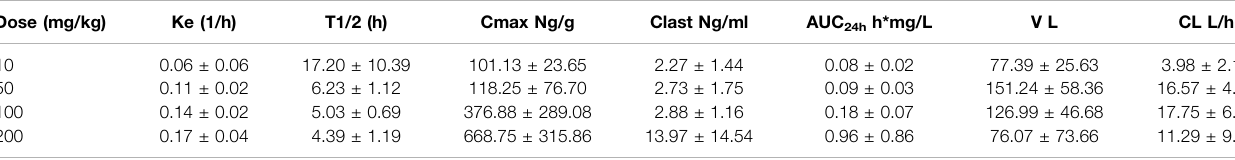
Values expressed represent group averages ± SD, single injection ( n = 4 per group).